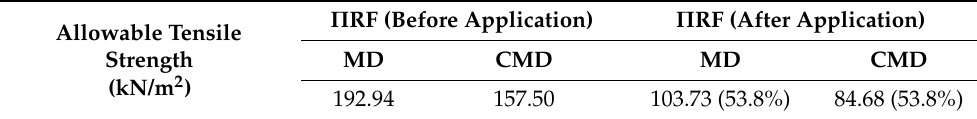
Table 9. Allowable tensile strength of LCP woven geotextile’s long-term performance model.